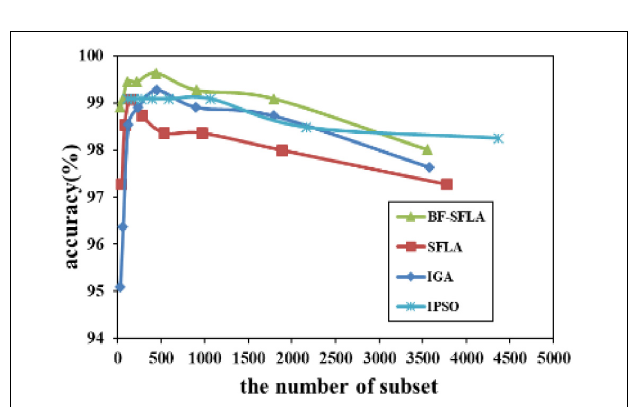
FIGURE 9 | The variation trend of classification accuracy and feature subset of DLBCL-Stanford.